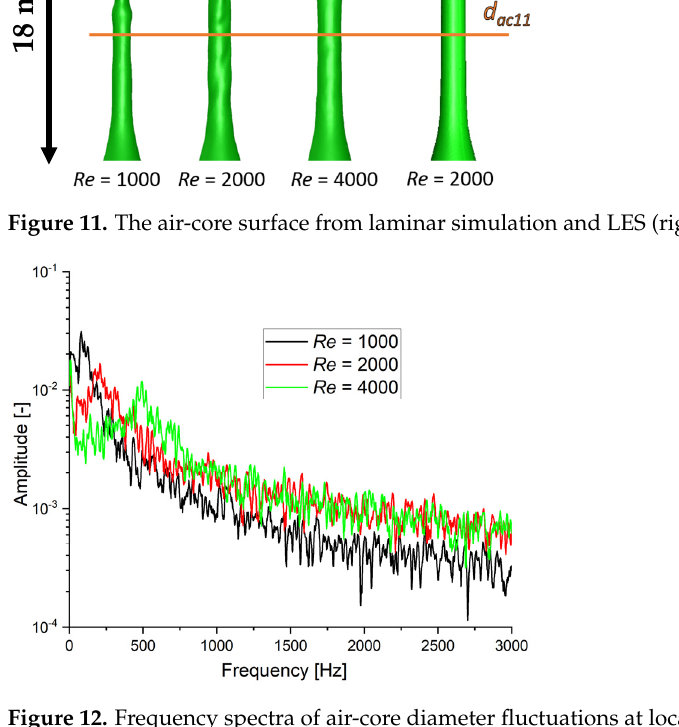
Figure 13. Frequency spectra of air-core diameter fluctuations at location ( left ): d ac2 , ( right ): d ac11 . Laminar simulation. 4. Conclusions The 2D and 3D numerical simulations of pressure-swirl atomizer internal flow were compared in transient and steady states with experimental data for Re = 1000, 2000 and 4000. Various numerical setups, including six turbulence models and several geometrical simplifications, were investigated.